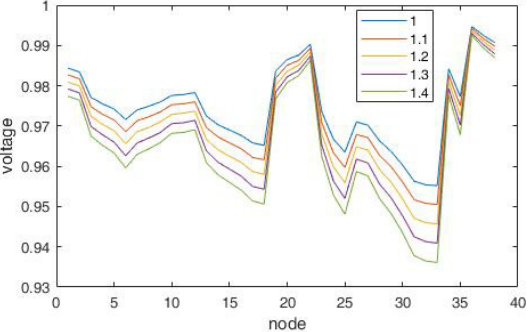
Figure 8. Voltage profiles with load